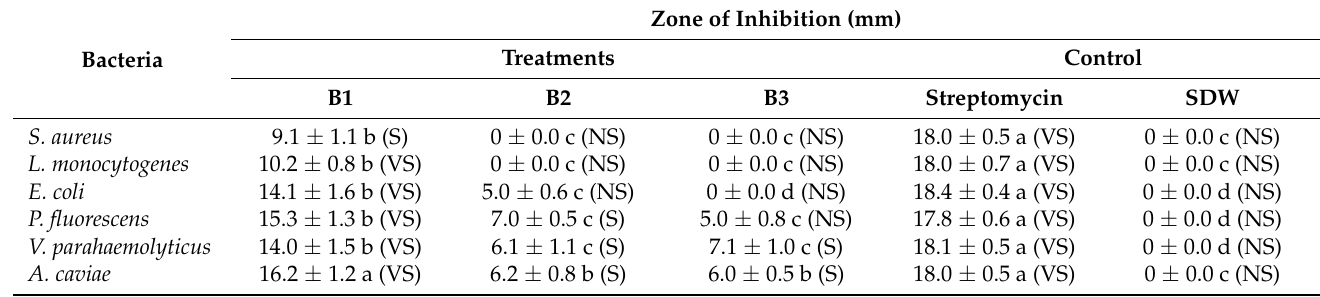
Table 5. Antimicrobial activity of berberis fruits against common food borne pathogenic